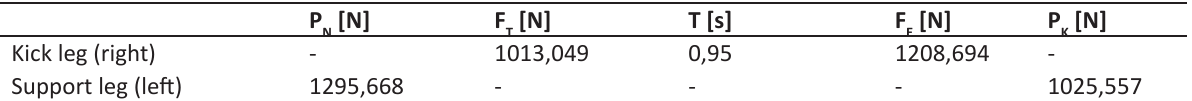
Table 1. Selected kinetic parameters for right leg front kick